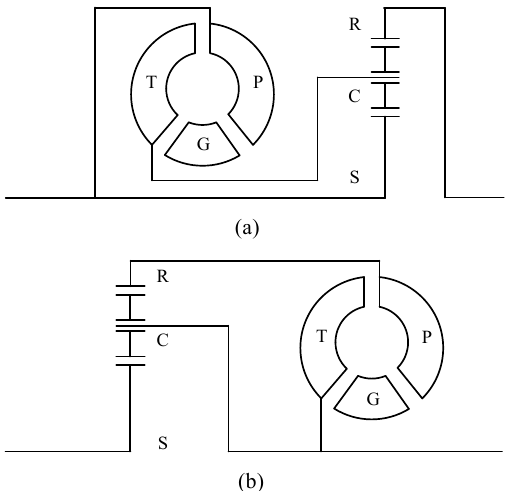
Figure 6. Two types of HMPSTs. ( a ) Input torque coupled architecture; ( b ) Output torque coupled architecture.